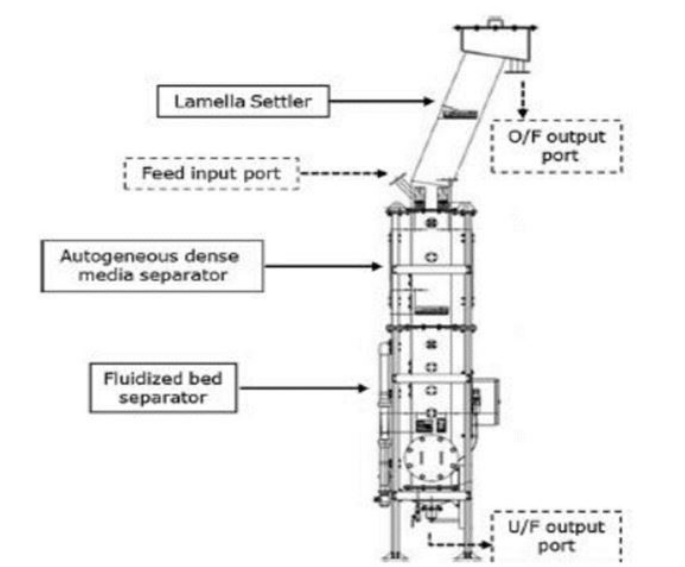
Figure 2. Schematic diagram of a Reflux Classifier (Amarieri et al.,